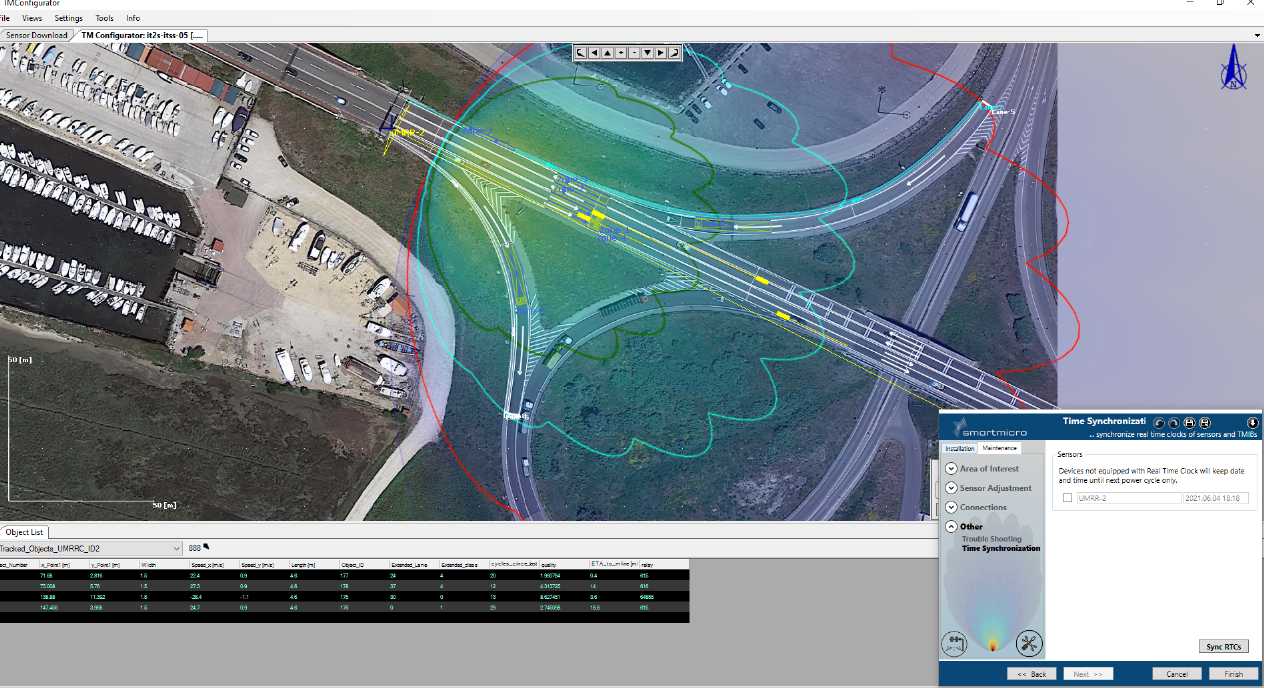
Figure 8. Traffic Management Configurator software by